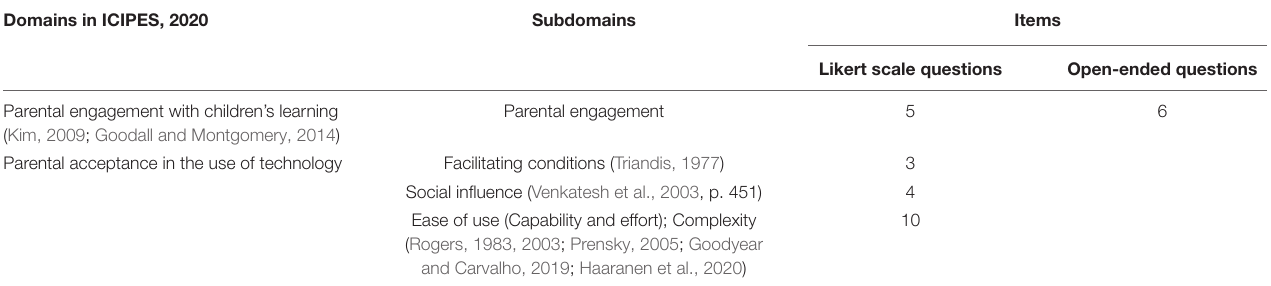
TABLE 2 | Themes included in the